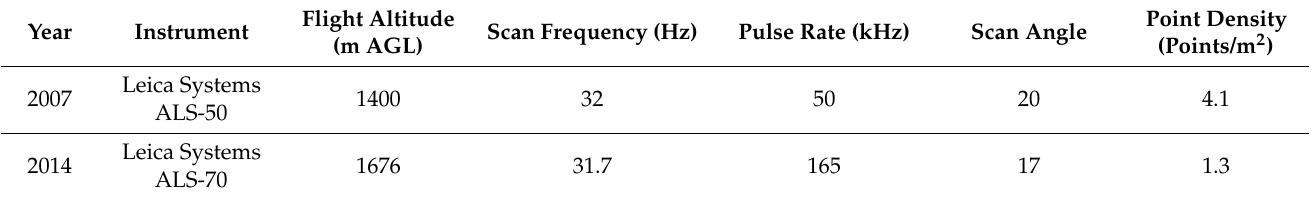
Table 1. Airborne LiDAR flight acquisition details for 2007 and 2014, acquired from the Sanborn Map Company, Inc and NOAA National Geodetic Survey,